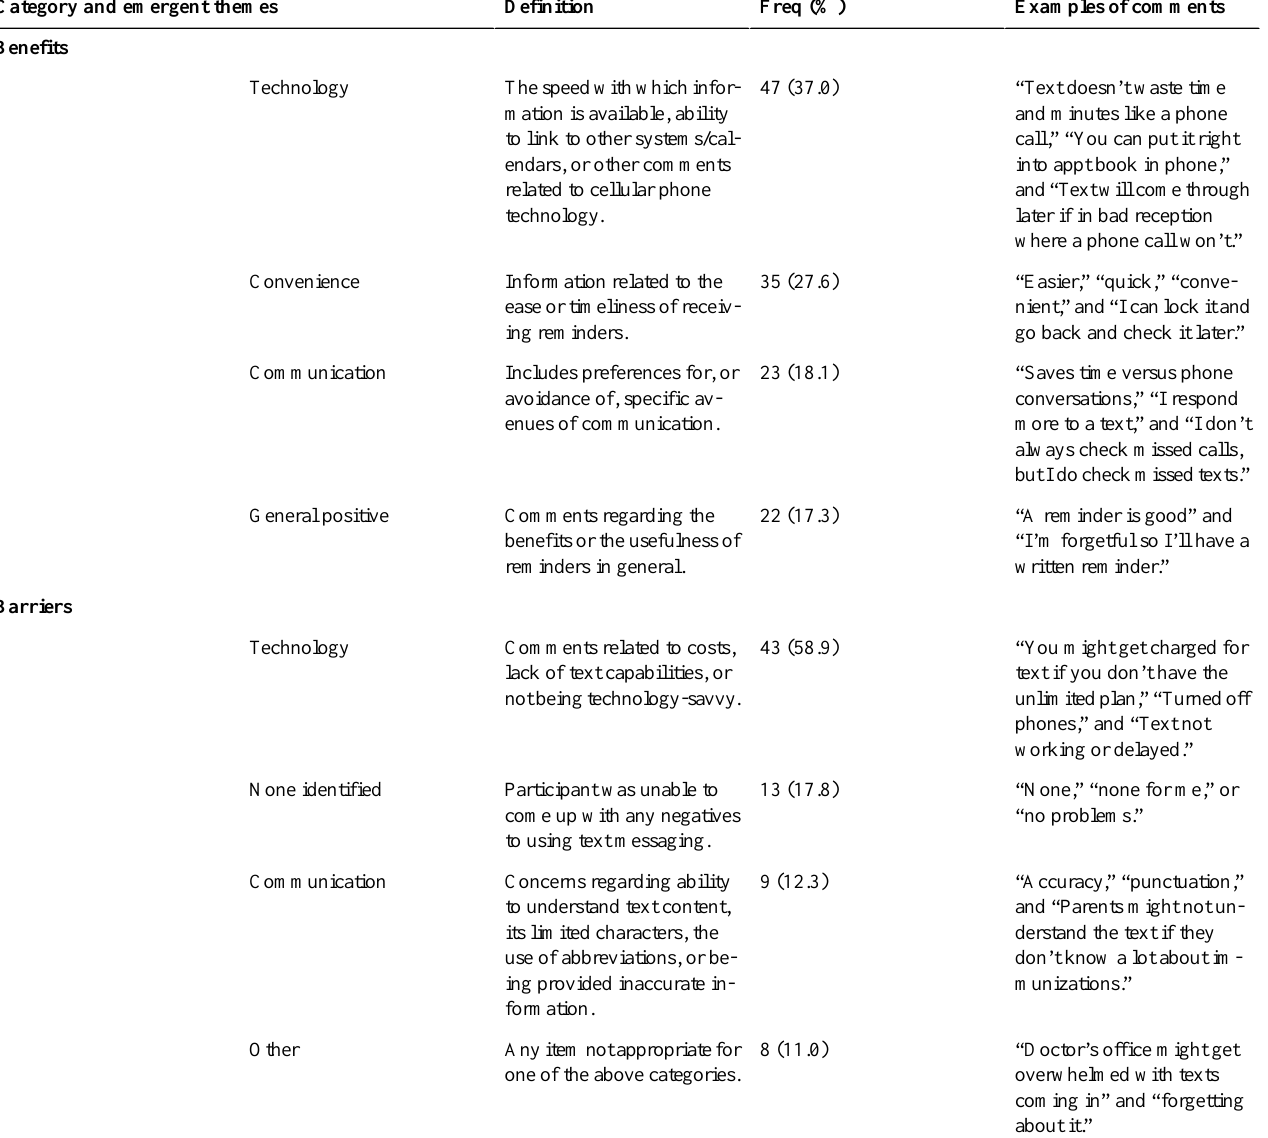
Table 1. Content analysis of participant comments (N = 200) about benefits and barriers to text message